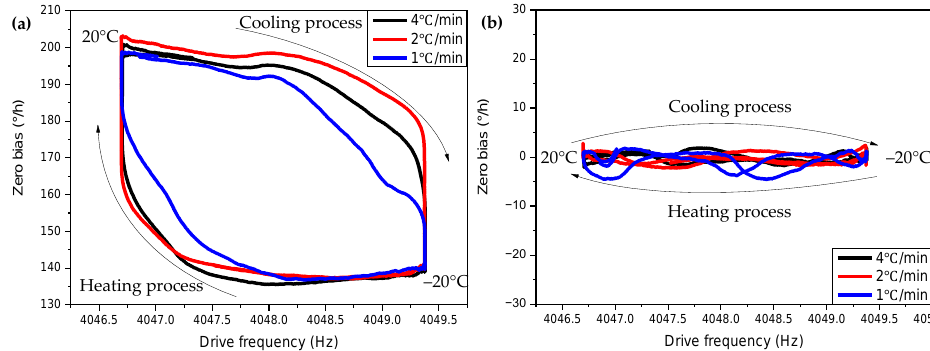
Figure 6. Zero-bias drift self-compensation results under different temperature change rates. ( a ) Be- fore compensation. ( b ) After compensation.